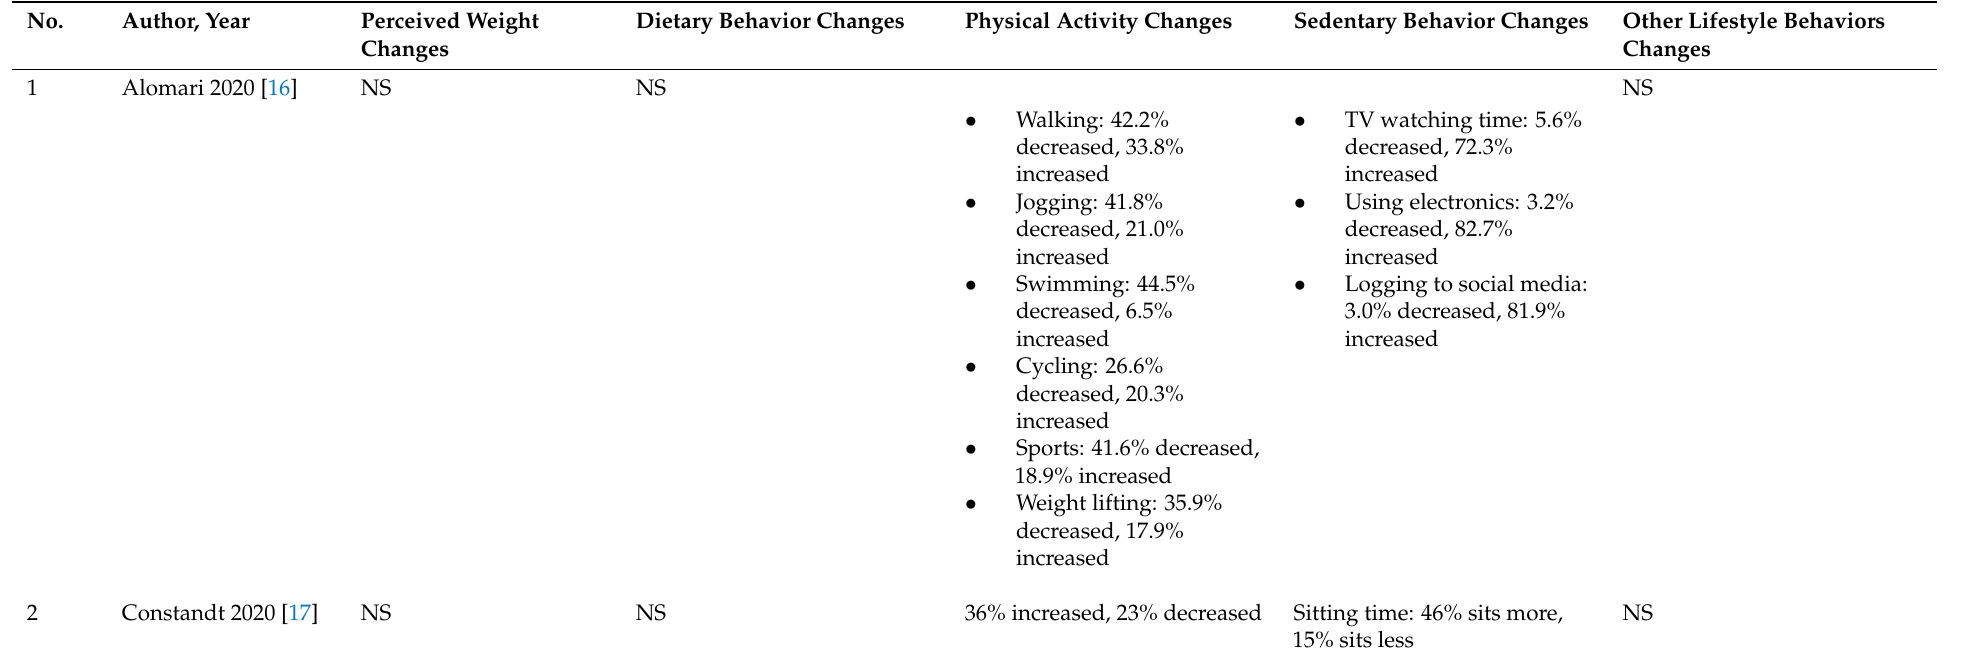
Table 2. Overall change in perceived weight status, dietary behaviors, physical activity behaviors, sedentary behaviors and other lifestyle